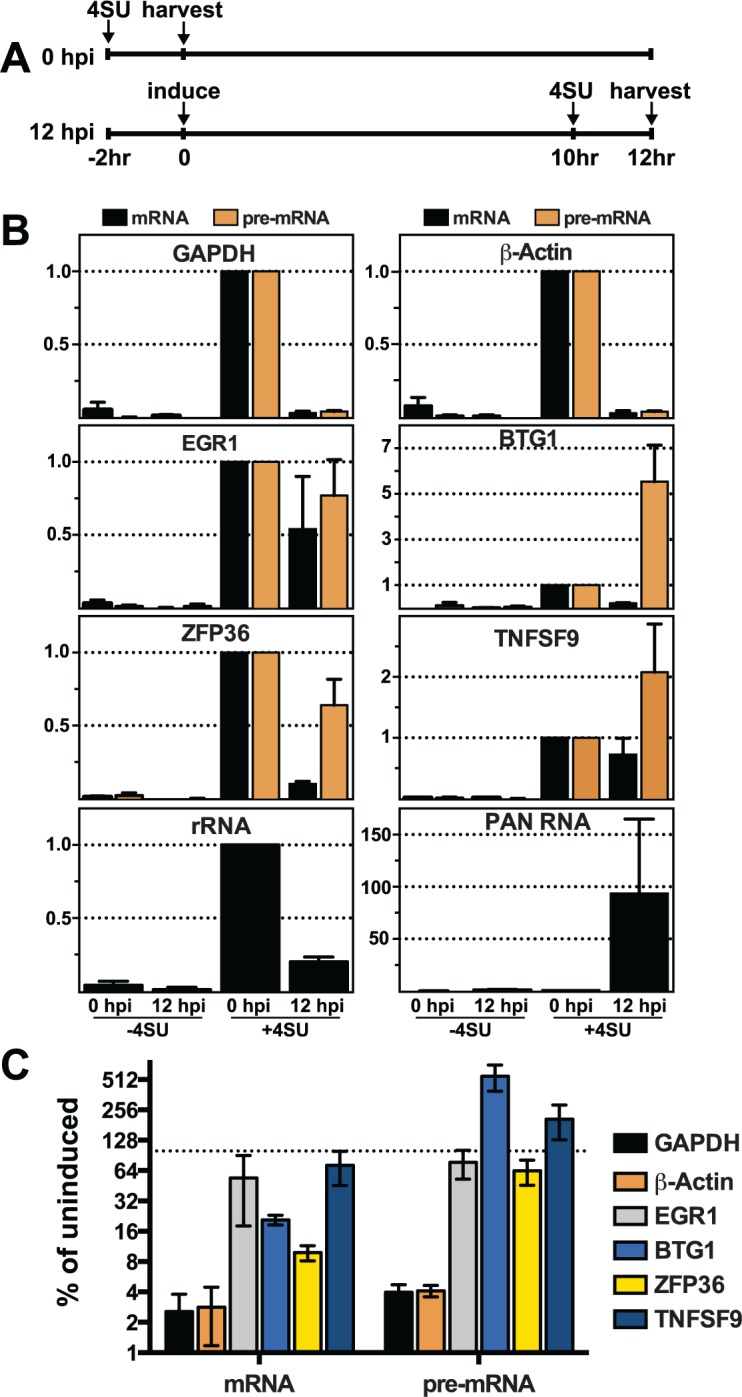
Newly made candidate ORF57-bound pre-RNAs have distinct kinetics during lytic reactivation.(A) Schematic of the time course used for 4SU metabolic labeling experiments. Cells were incubated with 4SU for two hours beginning at -2 and 10 hpi. Cells were collected and RNAs were extracted at 0 and 12 hpi, respectively. (B) Newly made RNA levels were monitored by RT-qPCR with the primers described in Fig. 5. The RT-qPCR values are listed relative to the 0 hpi samples which were set to 1.0. Note that the y-axis scales differ between the panels. The-4SU samples were collected at the same time and processed alongside the other samples, but the cells were not treated with 4SU. Mean values are shown and error bars are standard deviation (n = 3). (C) The data from (B) were plotted for direct comparison between controls (GAPDH and β-actin) and ORF57-bound candidates (EGR1, BTG1, ZFP36, and TNFSF9). The y-axis is on a log scale and the values are presented as the percent relative to the uninduced samples. The dotted line represents 100%.